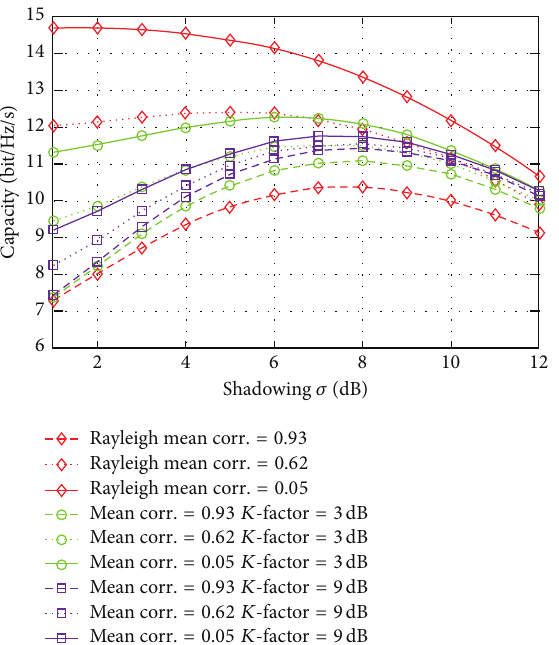
Figure 14: Distributed MIMO capacity versus shadowing level for correlated system with composite fading, Rayleigh and Rician (with different 𝐾